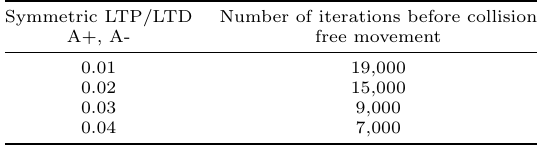
Table 1: Learning behaviour with different A + and A − pa- rameters Symmetric LTP/LTD A+,